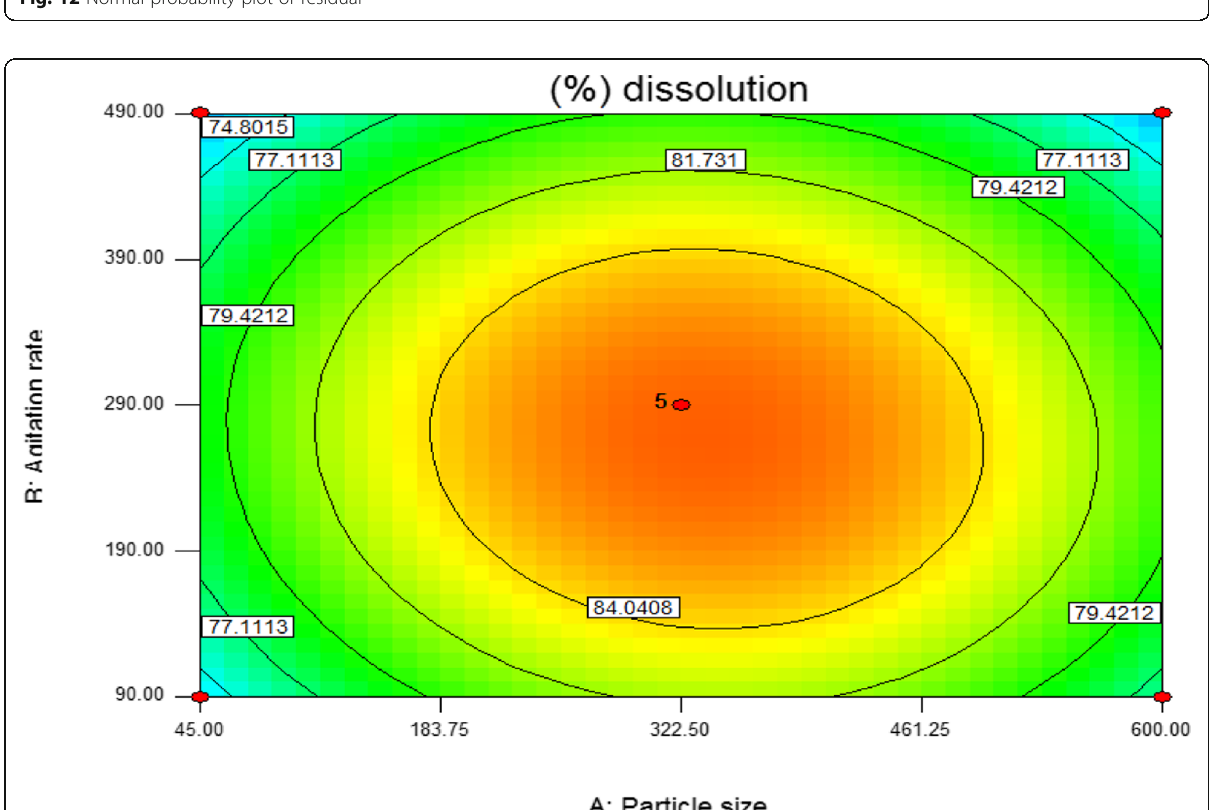
Fig. 12 Normal probability plot of residual